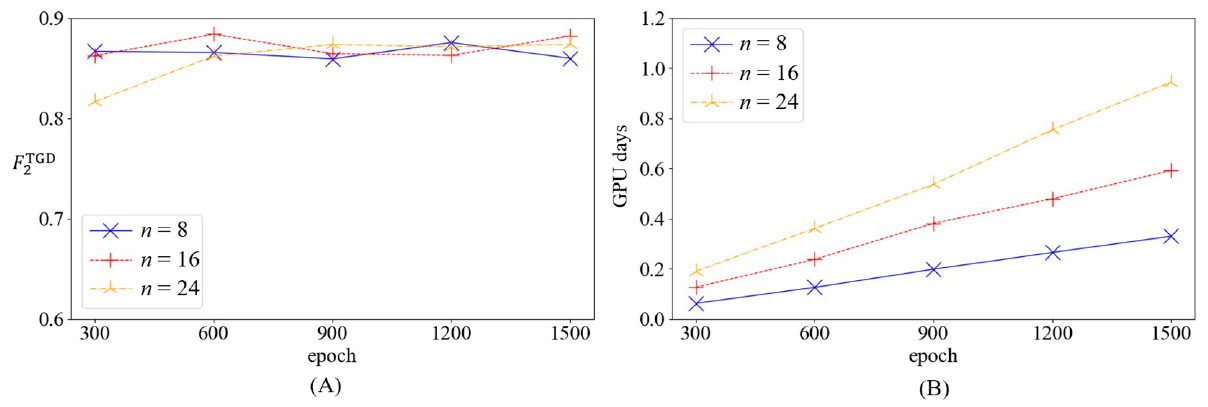
Figure 11. ( A ) Comparison of F TGD for models with different hyperparameter combinations; ( B ) comparison of training time for models with different hyperparameter combinations.